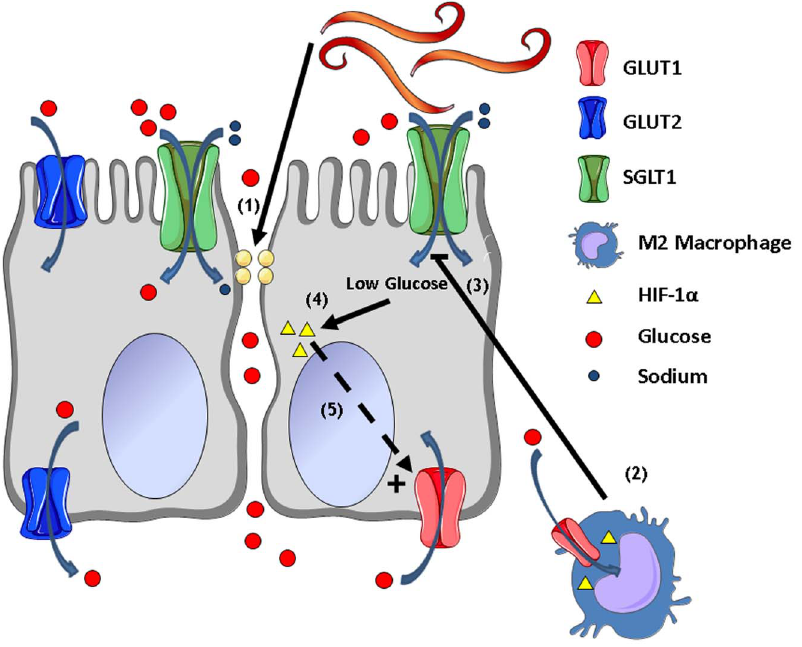
Figure 6. Model for changes in epithelial glucose handling in response to N.brasiliensis infection. (1) Infection induces a STAT6- dependent increase in mucosal permeability and (2) recruitment of alternatively activated macrophages (M2). (3) There is a M2-dependent inhibition of epithelial SGLT1 activity and M2-independent down-regulation of GLUT2. (4) This stresses the cell leading to activation of HIF-1 a and up-regulation of the constitutive insulin-dependent GLUT1. This transporter serves as the major mechanism for glucose entry into the cell. Thus, parasitic nematode infection results in a ‘‘lean’’ epithelial phenotype as a result of a shift from insulin-dependent to insulin-independent glucose transporters. The increased permeability (1) enhances the contribution of paracellular absorption of glucose to maintain body weight during